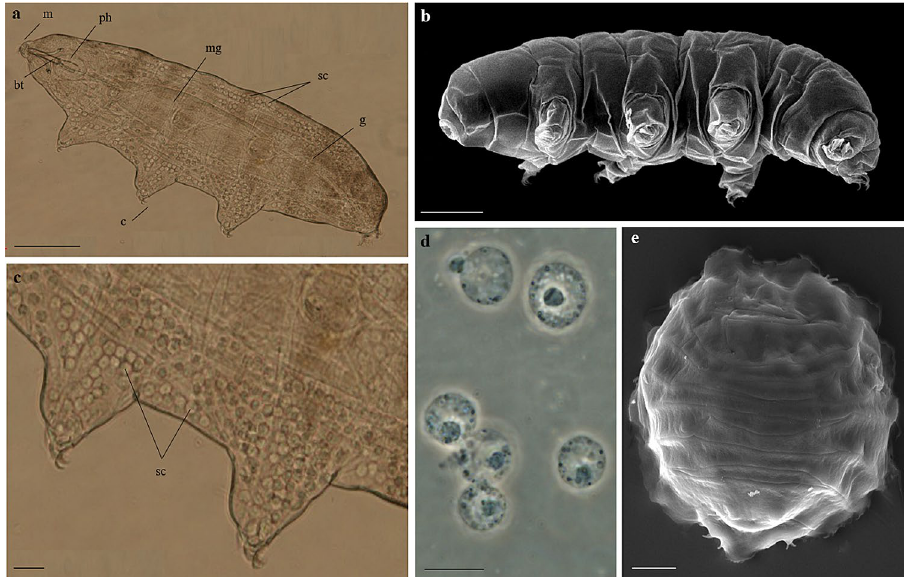
Figure 1. Paramacrobiotus spatialis . ( a ) Specimen in toto and in vivo. ( b ) Specimen in toto. ( c ) Magnification of image ( a ) showing storage cells in the body cavity in correspondence to the second and third pair of legs. ( d ) Storage cells in vivo. ( e ) Desiccated specimen (tun). ( a , c , d ) LM (PhC), ( b , e ) SEM. Scale bars: a = 100 µm, b = 50 µm, c, e = 20 µm, d = 10 µm. bt = buccal tube; c = claws; m = mouth; mg = midgut; g = gonad; ph = pharynx; sc = storage